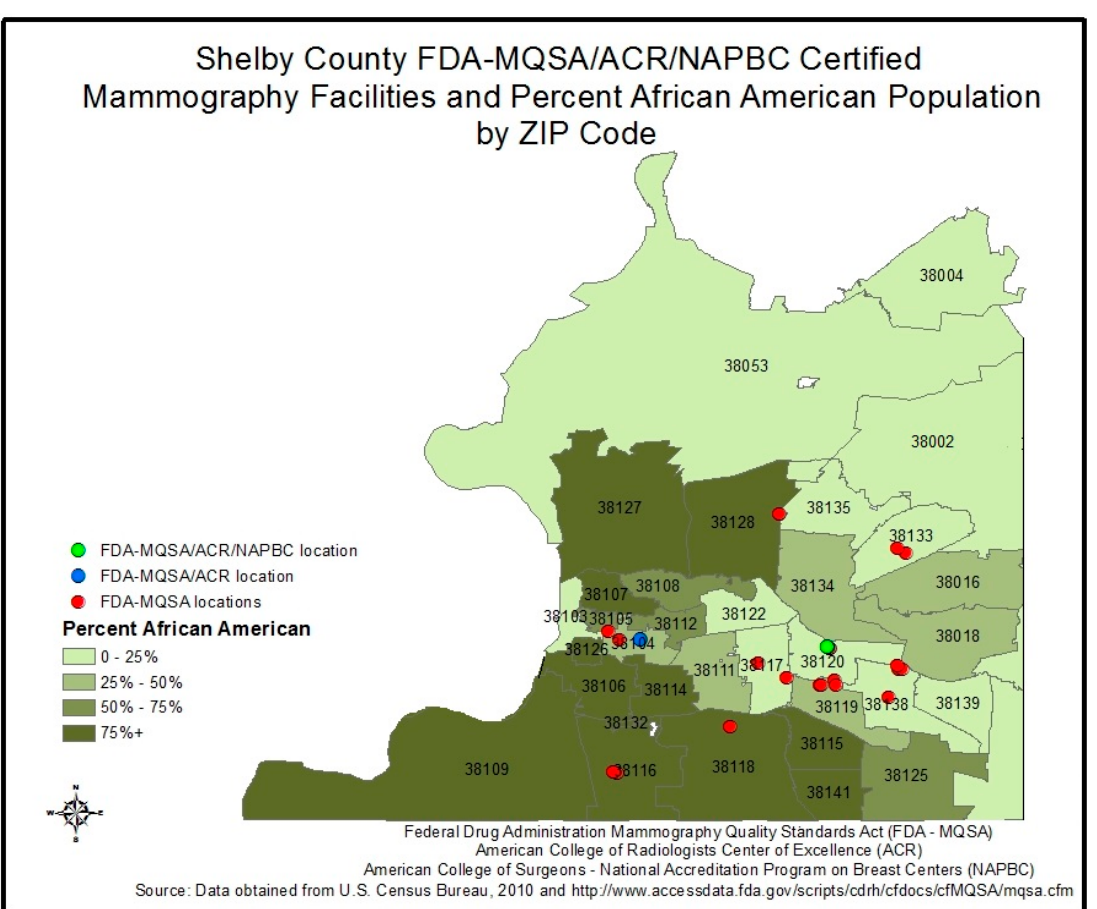
Figure A1. Shelby County FDA/MQSA/ACR/NAPBC Certified Mammography Facilities.